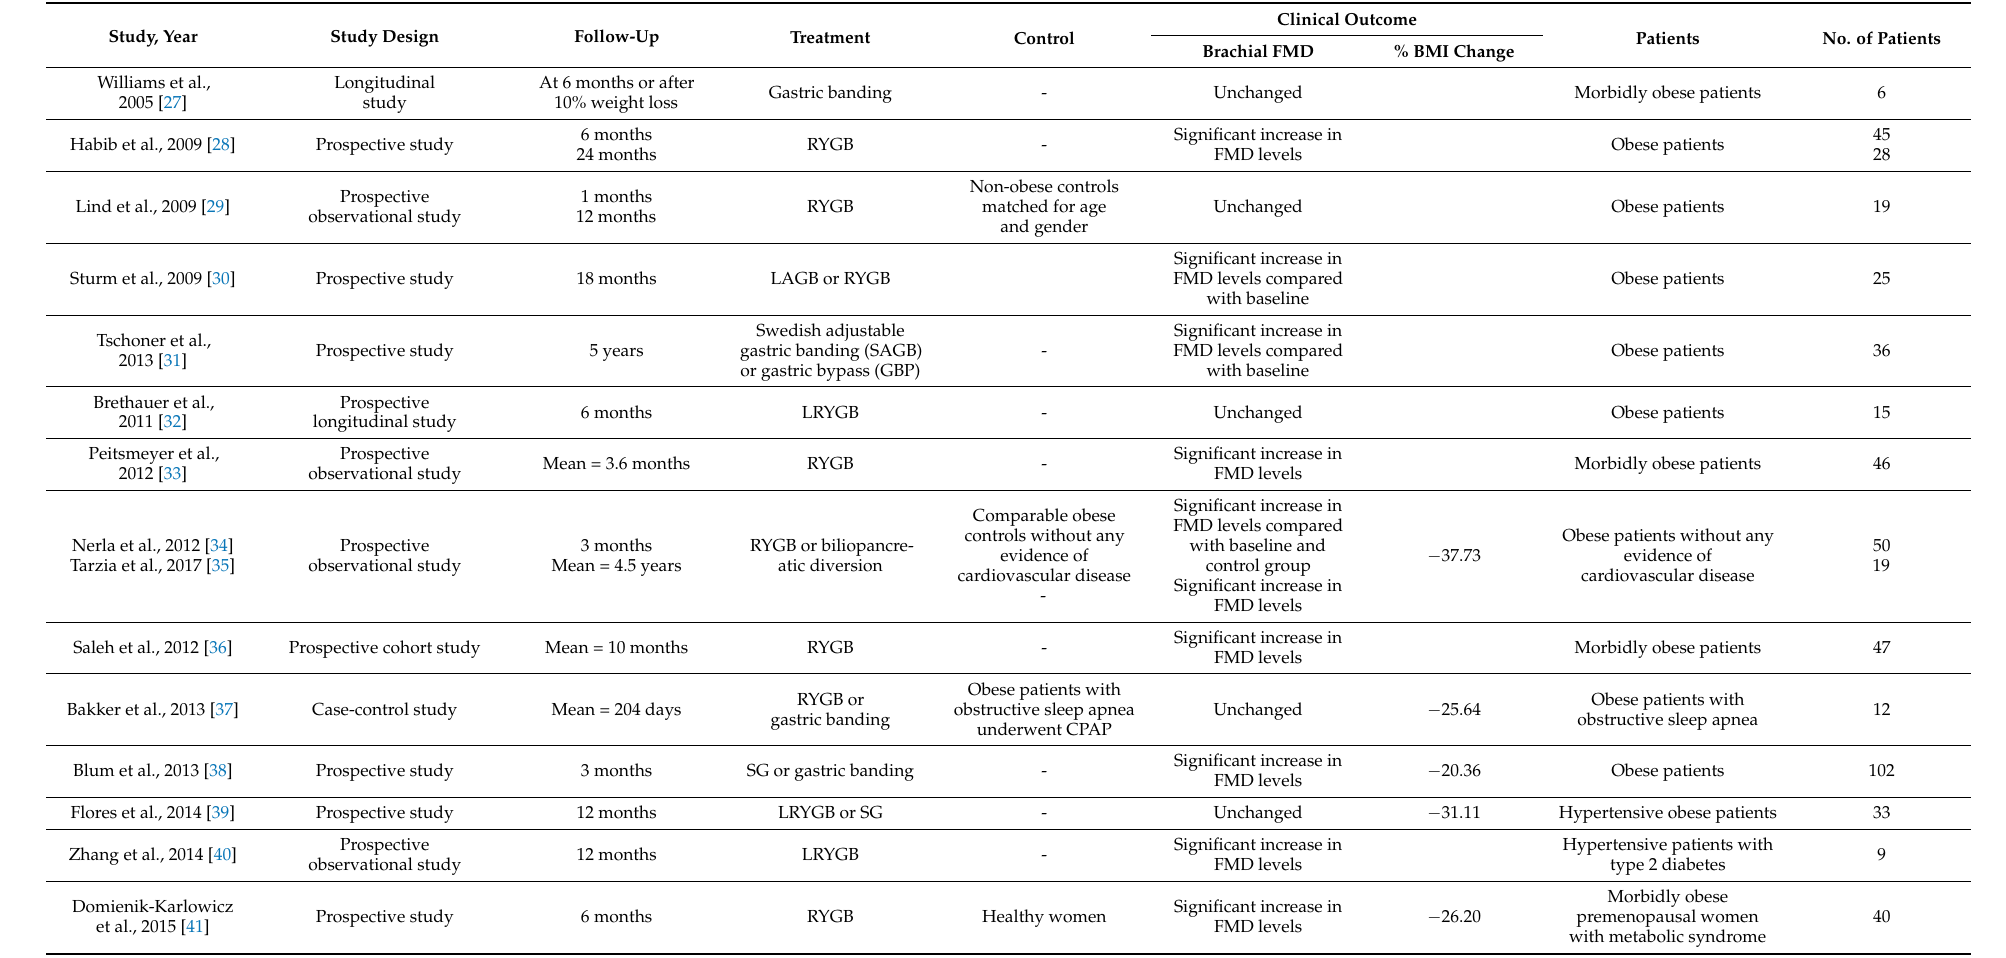
Table 2. Characteristics of studies measuring